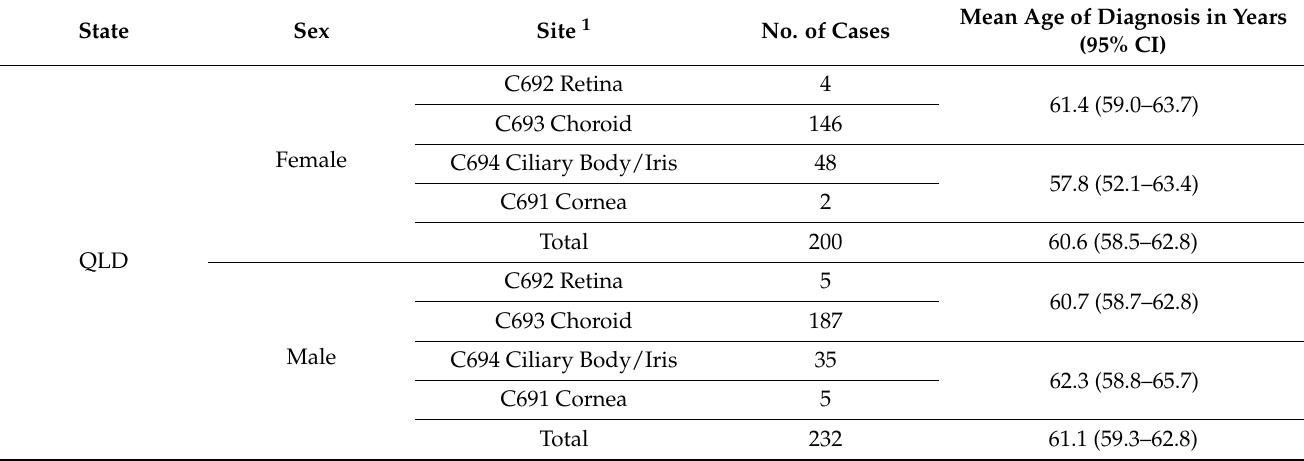
Table 1. Demographics of cases included in this